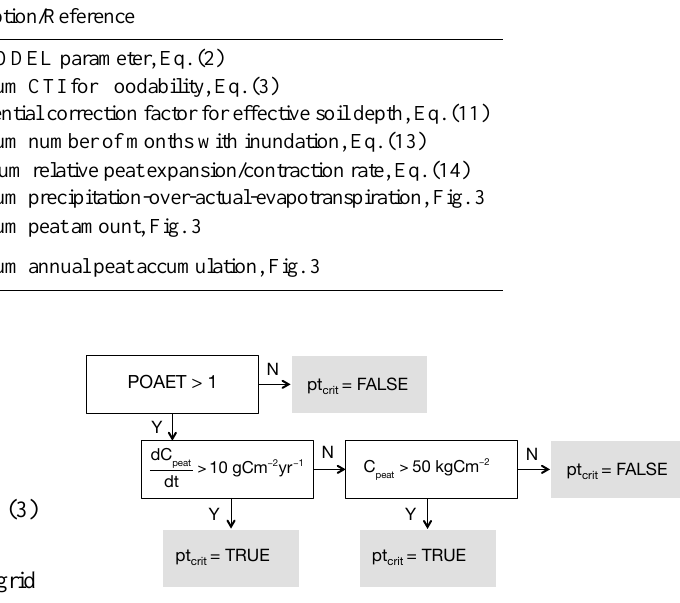
Figure 3. Illustration of decisions determining the criterion for peat- land expansion pt crit . The decision tree is evaluated starting in the upper-left box and variables are computed using the peatland bio- geochemistry model of LPX-Bern (Spahni et al., 2013) based on LPJ-WHyMe (Wania et al., 2009a, b).